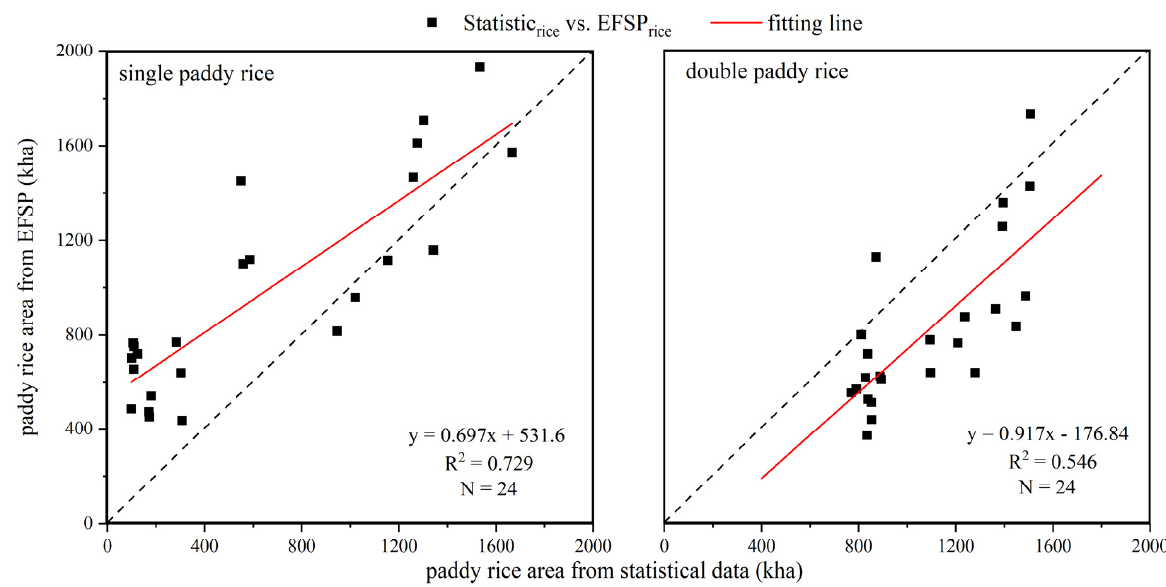
Figure 9. Province-level comparisons of area estimates of single and double paddy rice planting